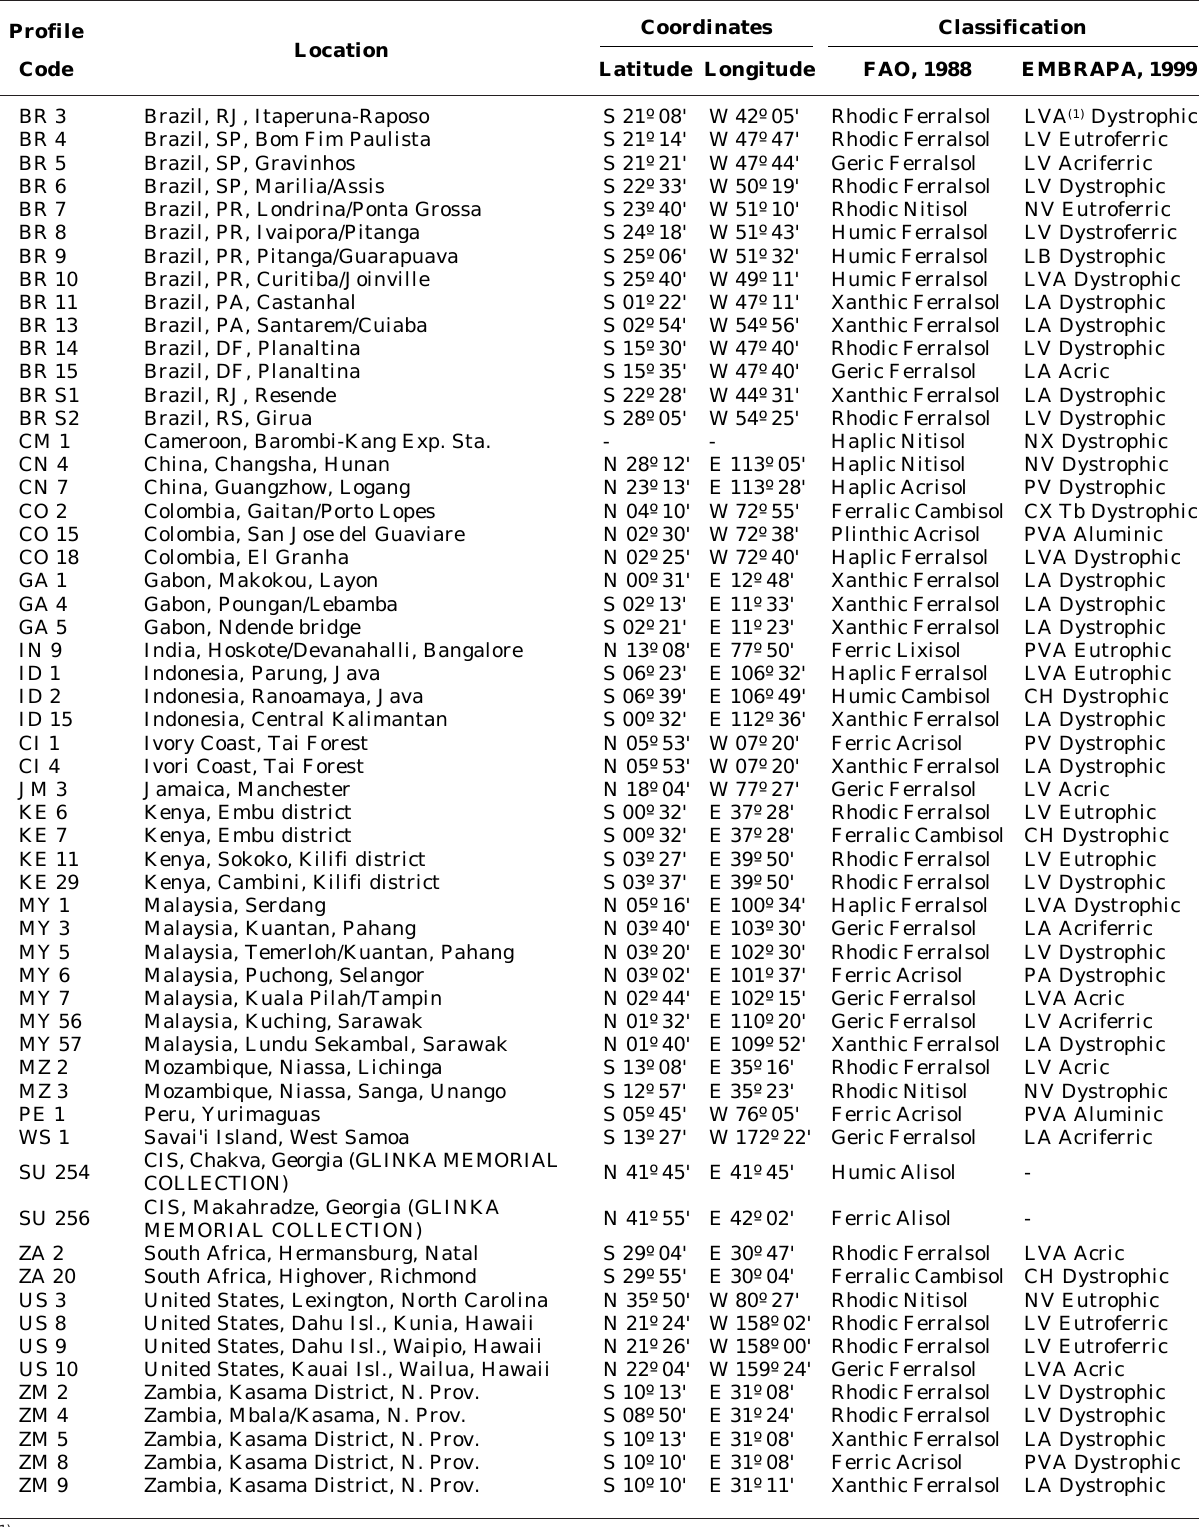
(1) LA = Yellow Latosol; LB = Brown Latosol; LVA = Red Yellow Latosol; LV = Red Latosol; PA = Yellow Argisol; PVA = Red Yellow Argisol; PV = Red Argisol; CX = Haplic Cambisol; CH = Humic Cambisol; NX = Haplic Nitosol; NV = Red Nitosol.